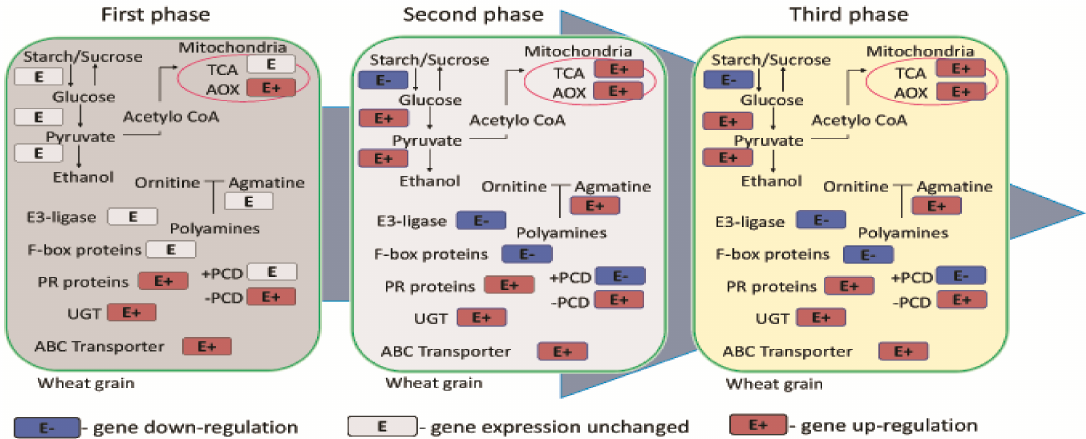
Figure 2. Metabolic pathway of the three main stages of infection caused by F. graminearum in wheat (adapted from Chetouhi et al. (2016) [50]). AOX: alternative oxidase, E: gene expression unchanged; E+: gene up-regulation; E − : gene down-regulation; PCD: programmed cell death; PR: pathogenesis-related genes; TCA: tricarboxylic acid; UGT: UDP-glucuronosyltransferase. Modifications: emphasis on gene expression profiles using “+” and “ − “ indicators, simplification of graphic